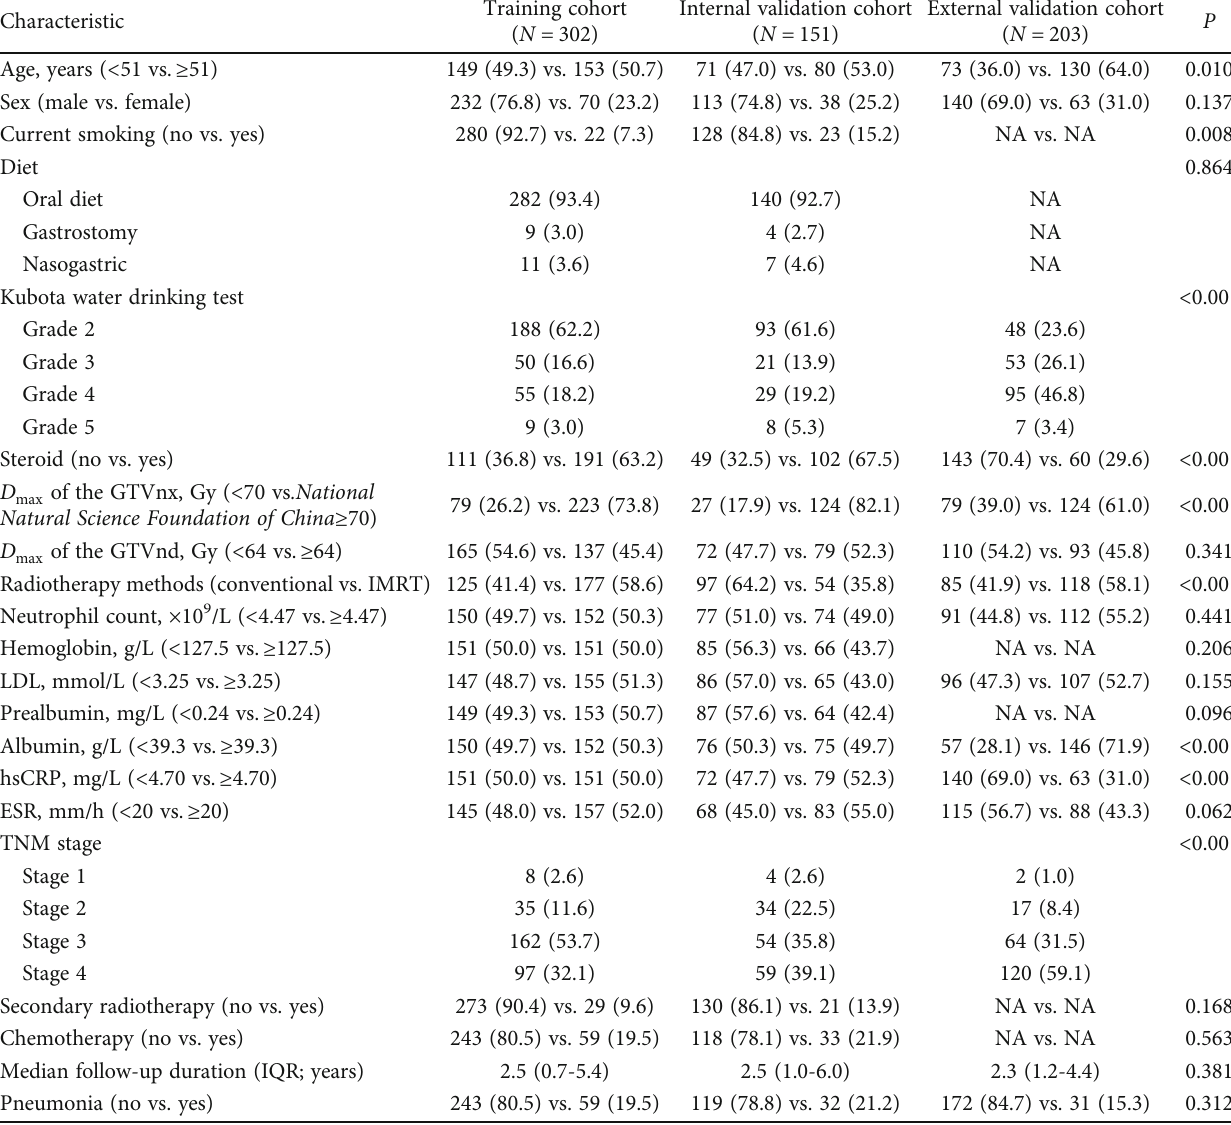
Table 1: Demographics of dysphagic patients after radiotherapy for